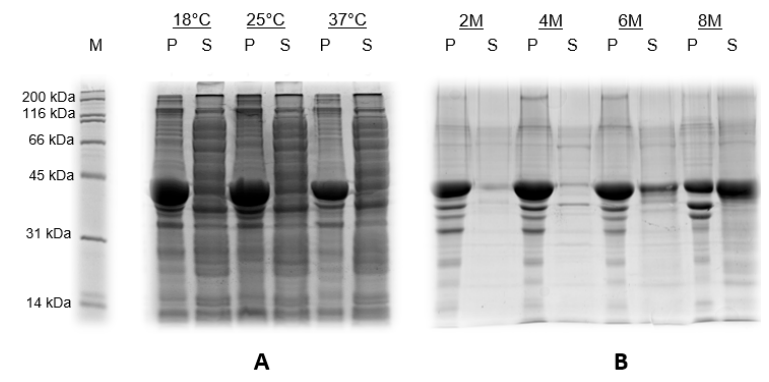
Figure 1. Expression and solubility of the recombinant CHIKV-E2 protein produced in E. coli BL21 (DE3). ( A ) Recombinant CHIKV-E2 produced in the pellet (P, insoluble) and supernatant (S, soluble) fractions at different induction temperatures (18, 25 and 37 °C). ( B ) Solubility of the recombinant protein at different concentrations of urea (2, 4, 6 and 8 M).